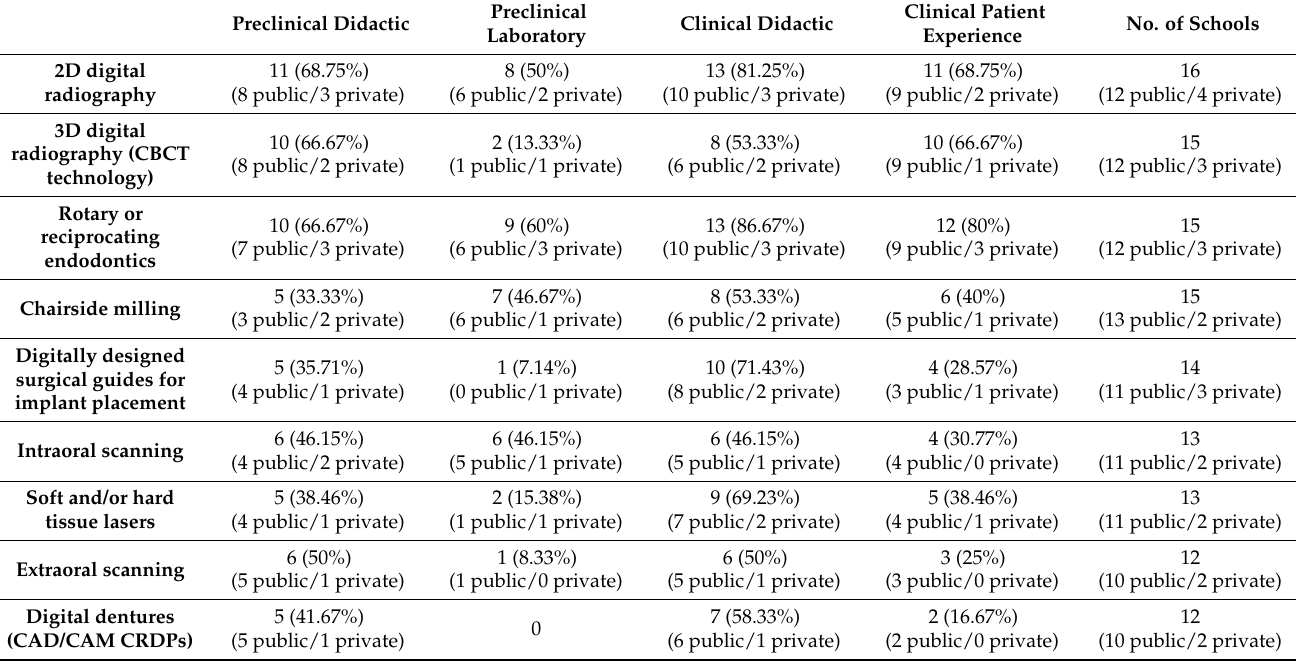
Table 1. Responses of 17 dental schools that implemented dental dentistry into their curriculum